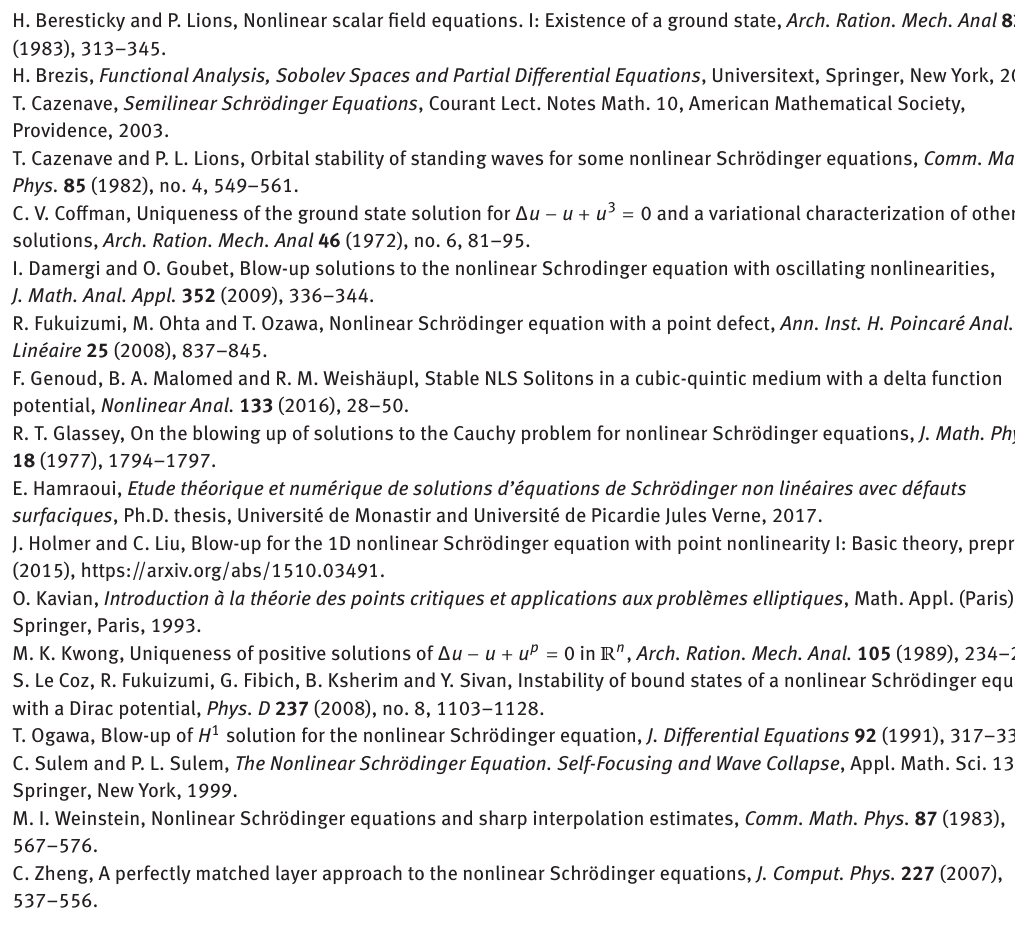
| 2 ] r 0 versus time for Z ∂r